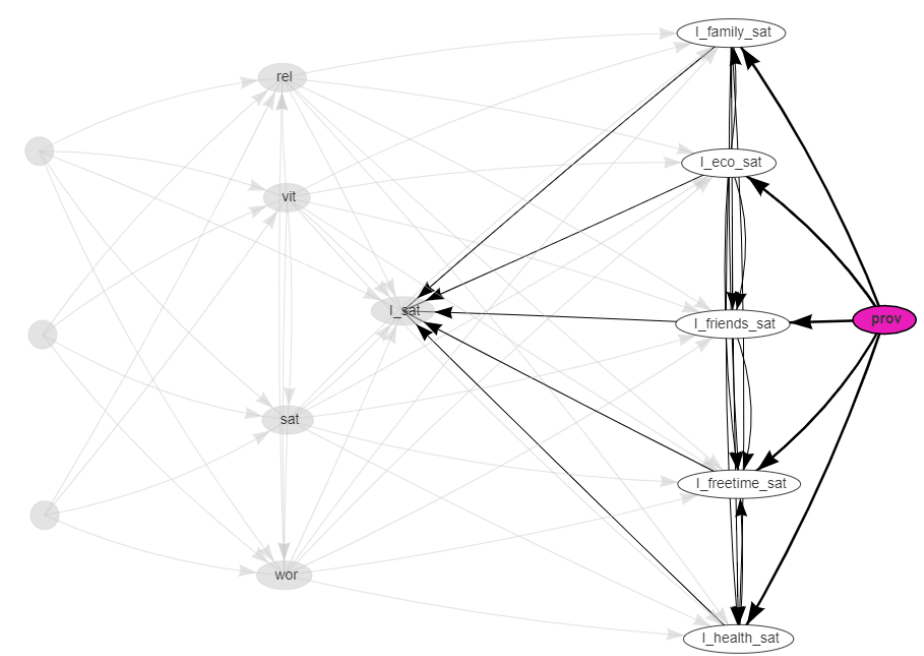
Figure 3. Social media data vs. survey data: Bayesian network highlighting the Italian provinces (purple). The children nodes of the province nodes are in